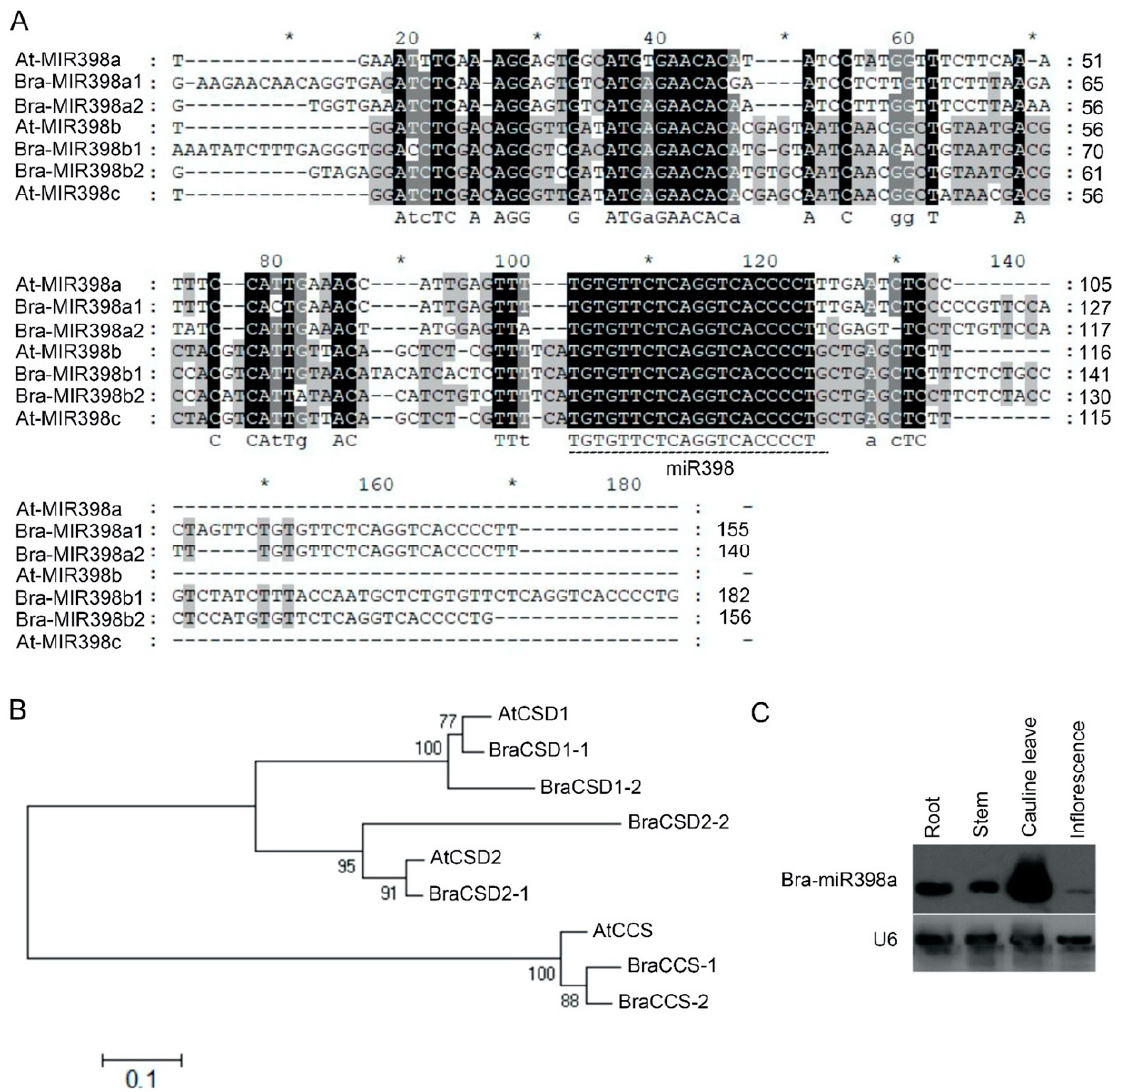
Figure 1. Characterization of miR398 and its targets in B. rapa . ( A ) Multiple alignment of pre-miR398 DNA sequences in Arabidopsis thaliana and B. rapa. The mature miR398 are represented by black solid lines. Asterisks represent 10 bp from the previous number. ( B ) Unrooted phylogenetic trees of miR398 targets based on their protein sequences in Arabidopsis thaliana and B. rapa . ( C ) Northern blotting showing mature miR398 abundance in different tissues of Bre plants.